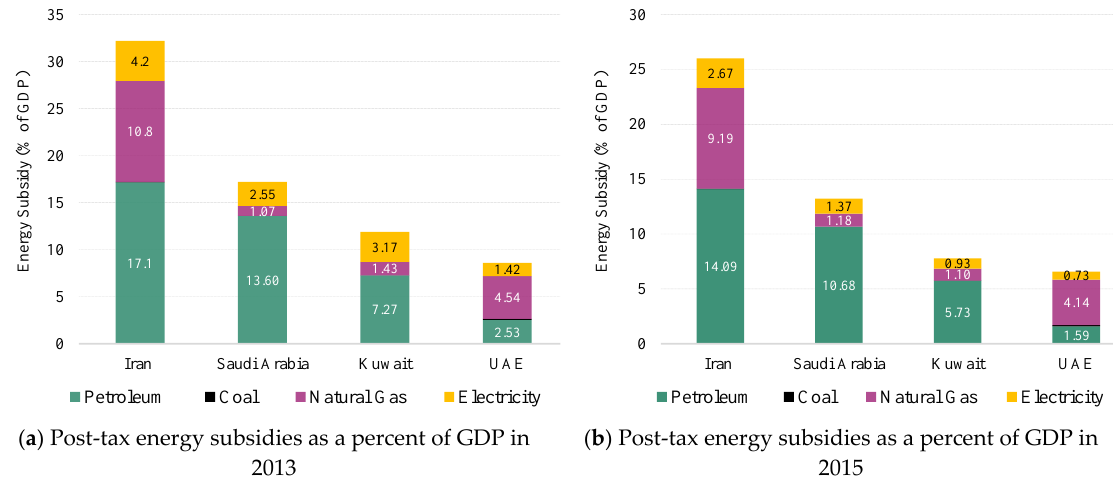
Figure 6. ( a ) Energy subsidy across the four countries as a percentage of total GDP in 2013; ( b ) energy subsidies as a percentage of total GDP in 2015. Based on data from [26,35].